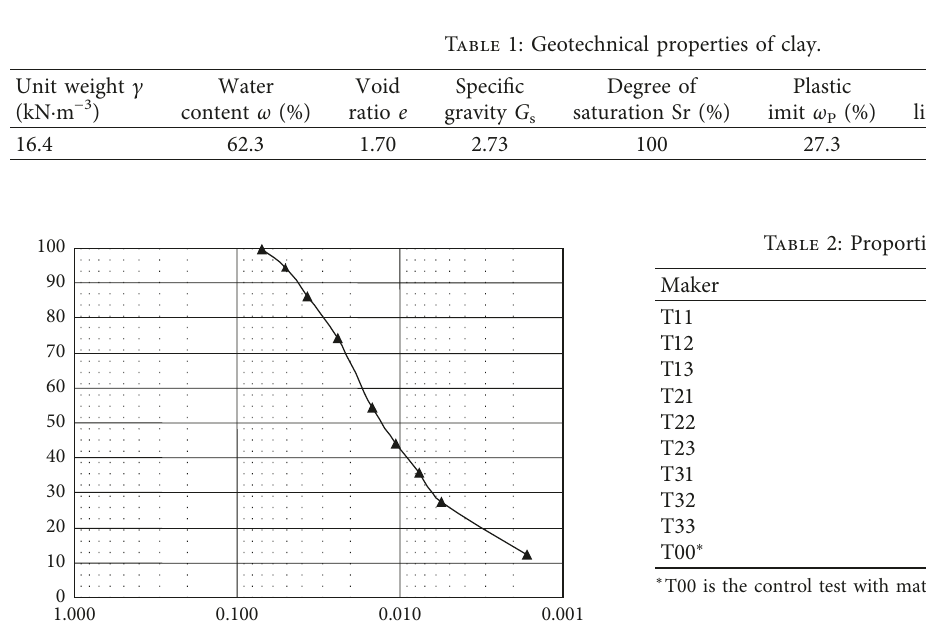
Figure 2: Particle size distribution of clay.